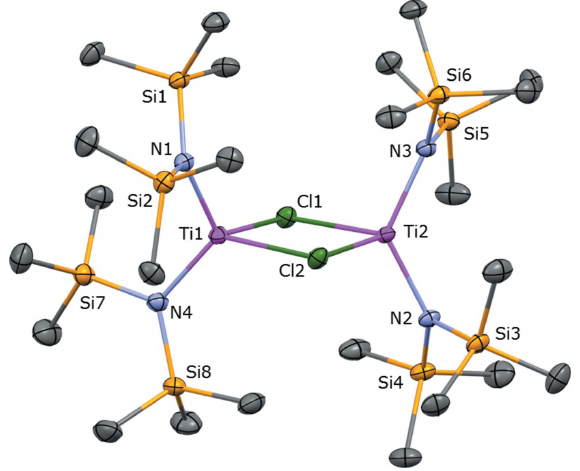
Figure 1 The molecular structure of the title compound with anisotropic displacement parameters set at the 50% probability level. Hydrogen atoms are omitted for clarity.